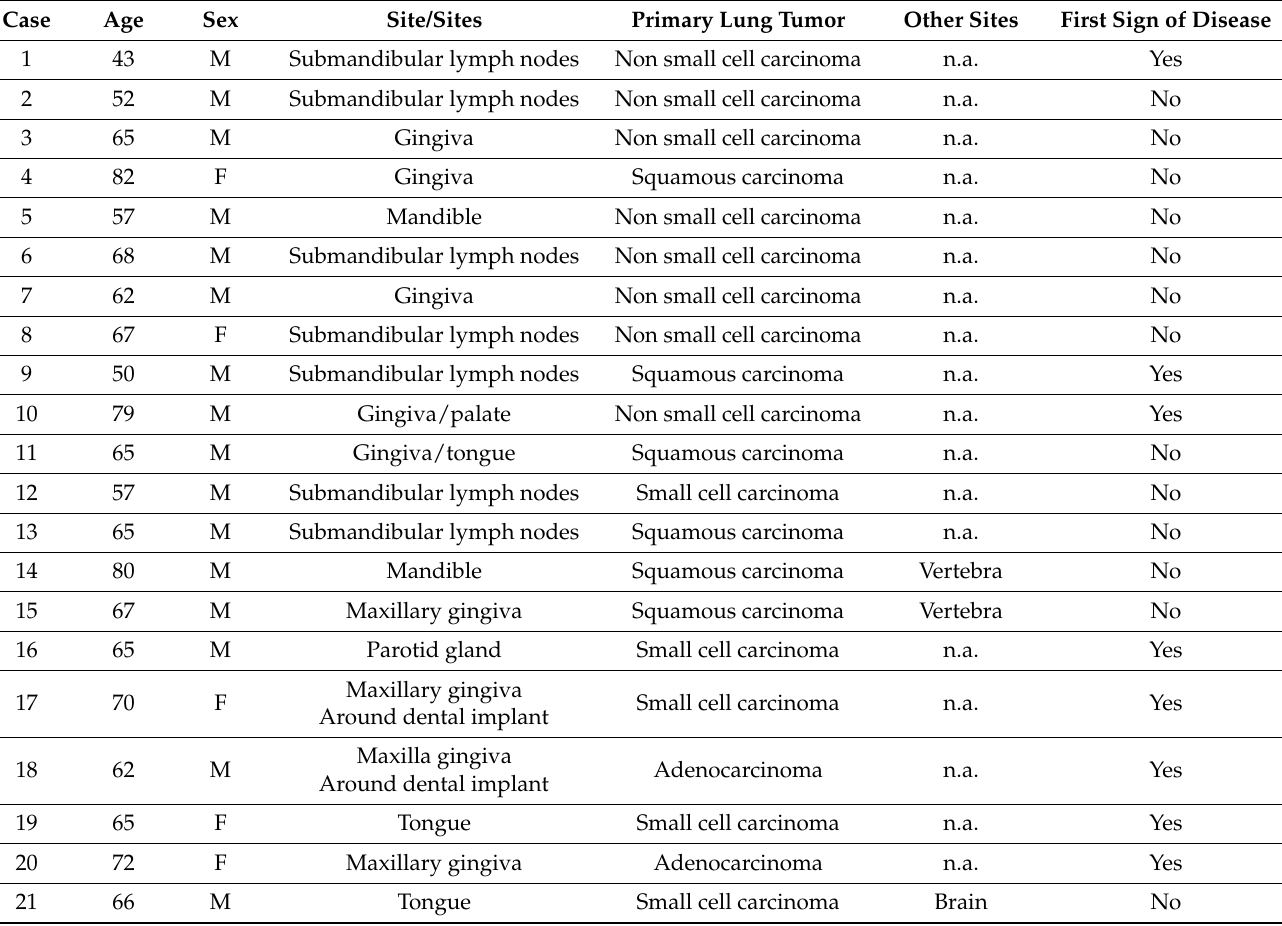
Table 1. Clinical data of